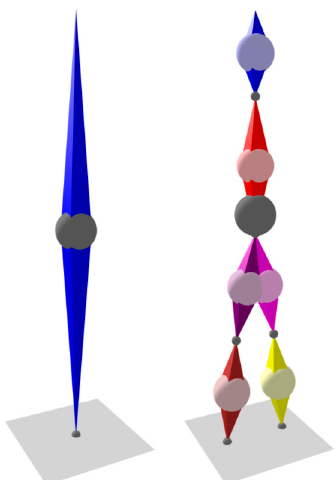
Figure 5. Single-segment and six-segment models. Balls indicate centre of mass: light colour— segment; dark grey—whole body.